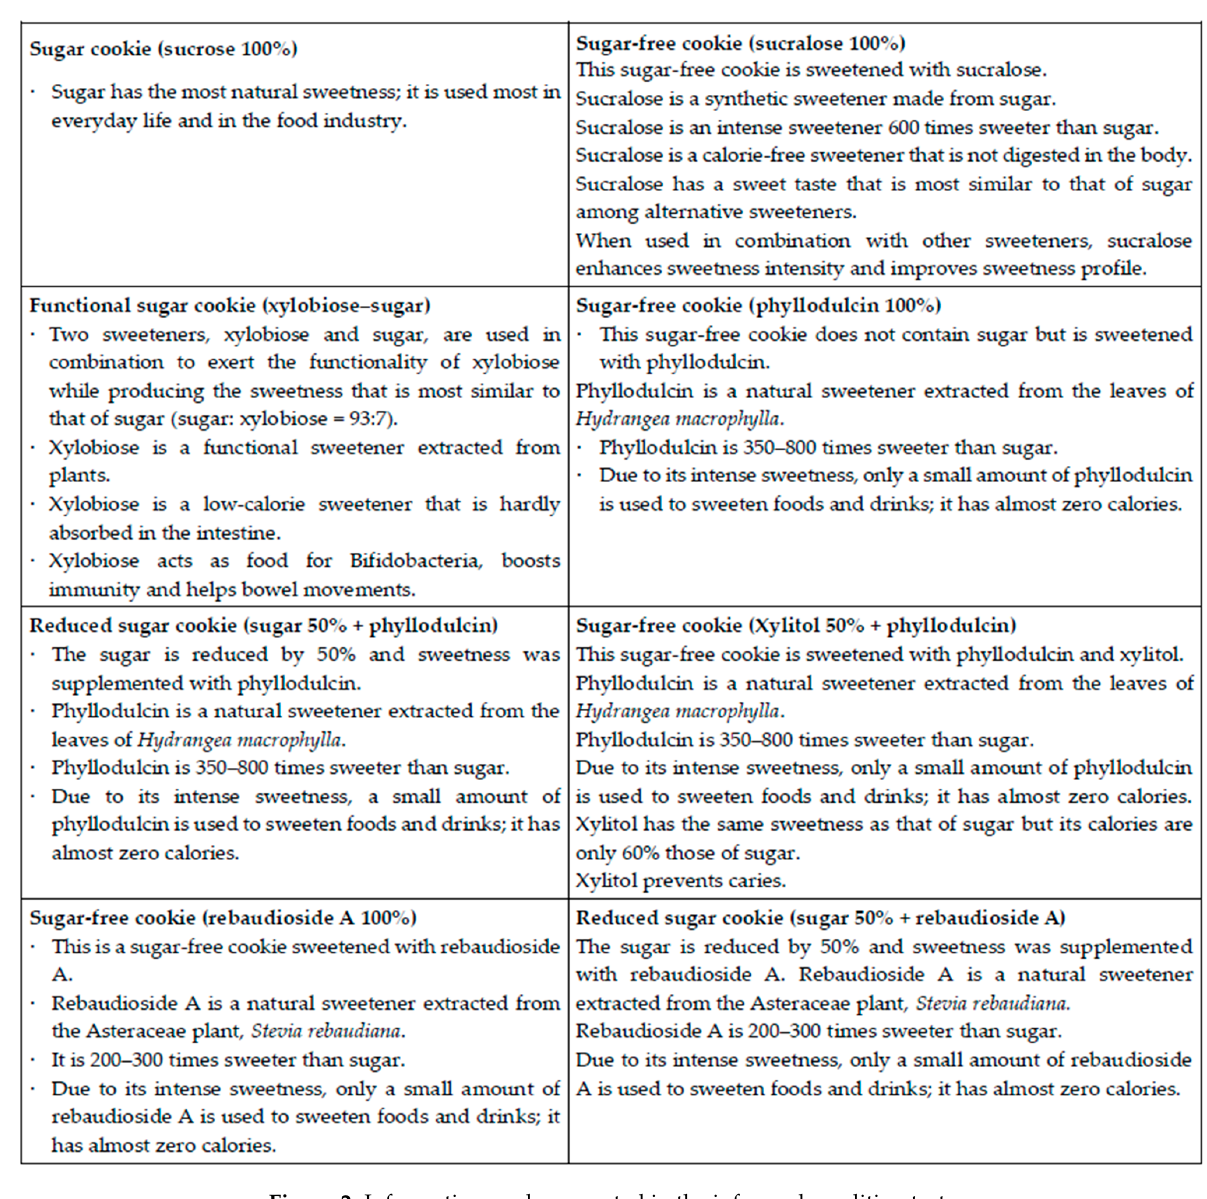
Figure 2. Information cards presented in the informed condition test.